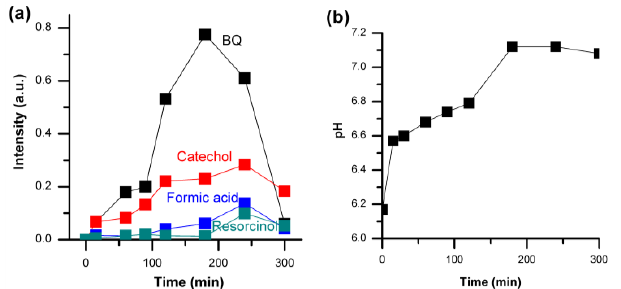
Figure 5. ( a ) Intermediate byproducts detected at various stages of photocatalytic degradation of phenol under visible light irradiation with ZnO nanorods as photocatalyst and ( b ) variations in the pH of the phenol solution during the degradation process.